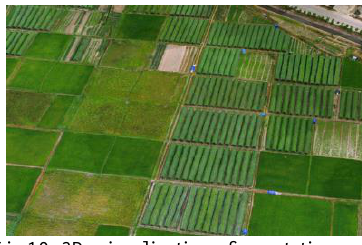
Fig 10. 3D visualization of vegetation area